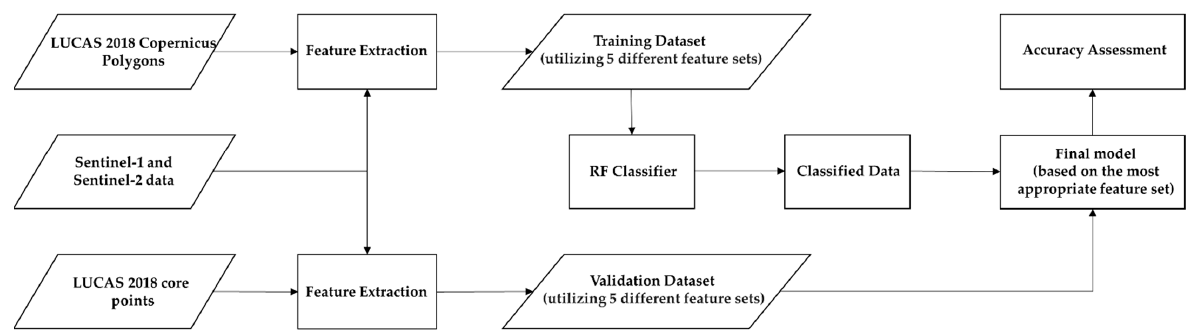
Figure 1. The main steps for the classification procedure.